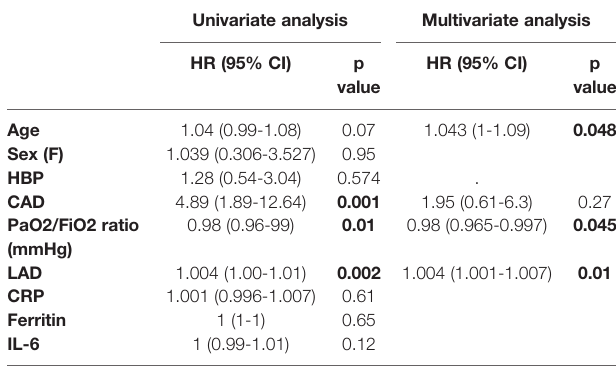
TABLE 6 | Baseline univariate and multivariate predictors of mortality in patients treated with biologic